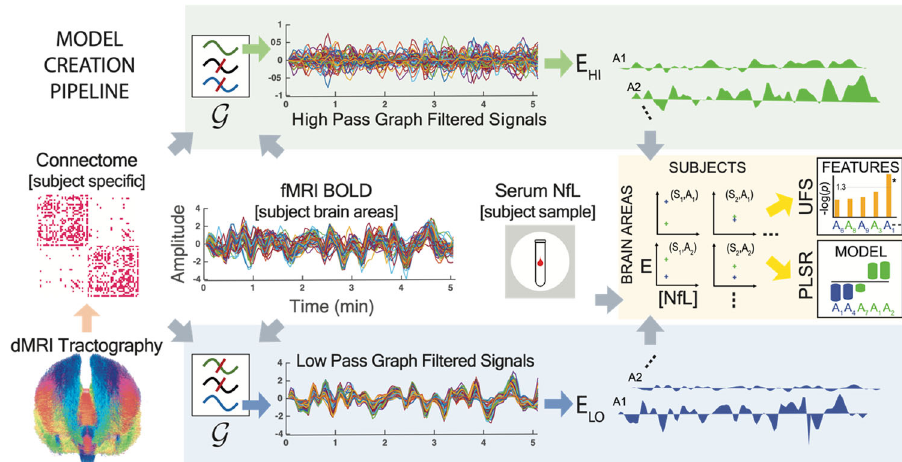
Fig. 1 Pipeline for statistical analysis for serum NfL levels and GSP-based features. Brain imaging data (structural (dMRI) and functional (resting state fMRI)), age, and serum NfL levels were recorded for every subject in the cohorts of 20 healthy subjects and 36 former athletes. For each subject, the dMRI and fMRI were pre-processed to extract the structural connectome (in the form of a 66 × 66 adjacency matrix for 66 cortical brain areas) and BOLD signal (in the form of a time series of length 308 seconds at each brain area considered), respectively. Subject-speci fi c graph fi lters derived from the eigen- decomposition of the structural connectome were constructed and used to extract different graph frequency components of the BOLD time series for all subjects. The energies (E HI and E LO , evaluated by ‘ 2 norm) of the different graph frequency components at different brain areas were investigated (energies of 2 graph frequency components per area for 66 brain areas per subject, i.e., 132 GSP-based predictors) for association with serum NfL levels using univariate feature selection (UFS), and their prediction power evaluated using a rigorous statistical analysis of PLS regression